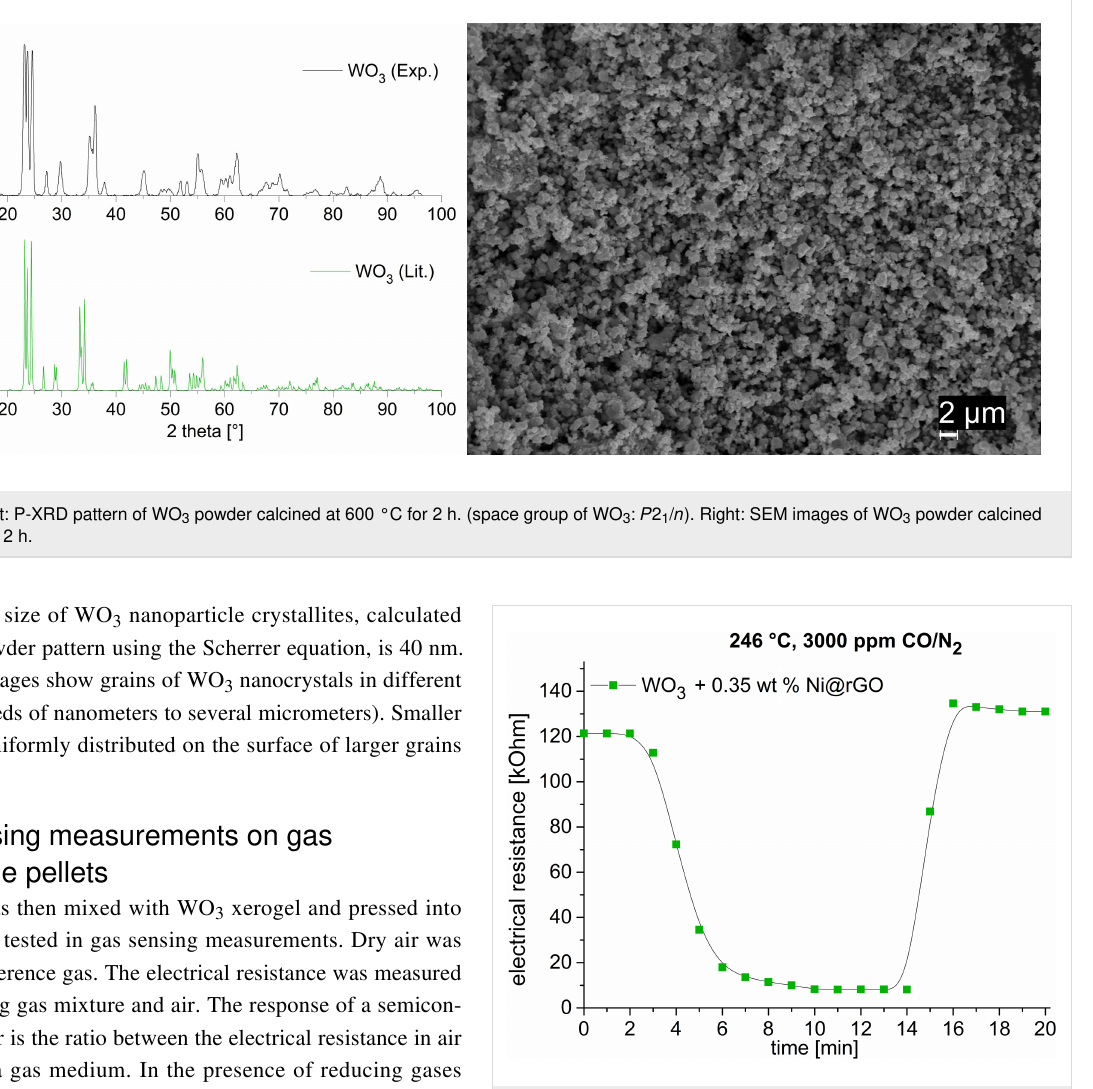
Figure 4: Time dependence of the sensor resistance values of the 0.35 wt % Ni@rGO/WO 3 sample under exposure to 3000 ppm CO